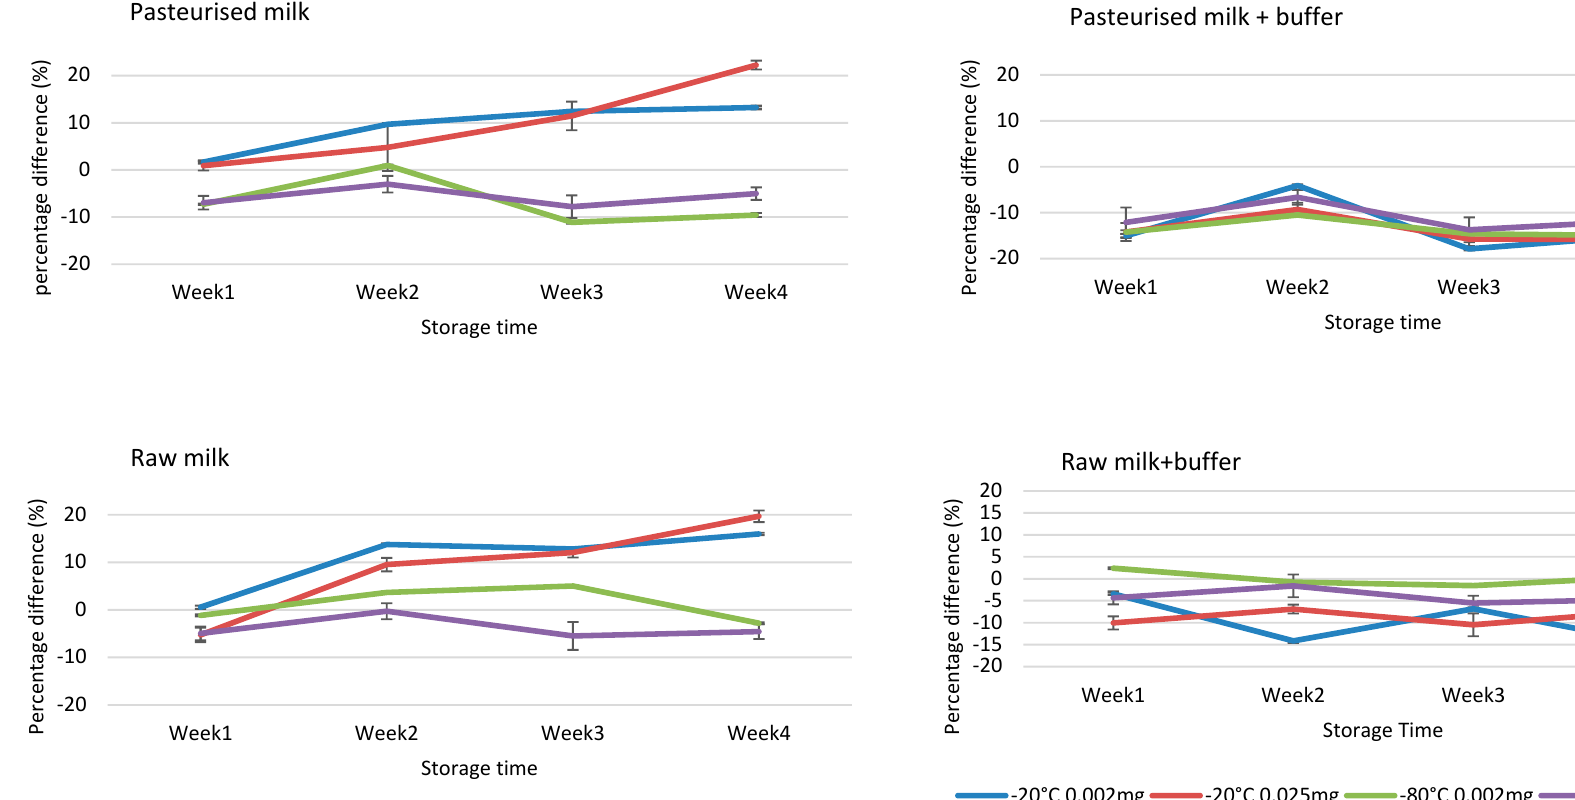
Figure 4. Stability assessment of NBPT and NBPTo in raw and pasteurised milk samples at concentrations 0.0020 and 0.0250 mg kg − 1 , storage temperatures − 20 and − 80 °C for 4 weeks. The residues were stable for four weeks in samples spiked at both 0.0020 and 0.0250 mg kg − 1 , stored at − 80 °C with or without buffer treatment. The addition of ammonium carbonate buffer in raw milk stabilised the residues at both storage temperatures for four weeks. Stability acceptance criteria = percentage difference of ±15% [23]. Concentration values obtained were expressed as sum of residues (NBPT Sum of residues ) ± SD using Equation 2, while percentage difference was calculated using Equation 1.